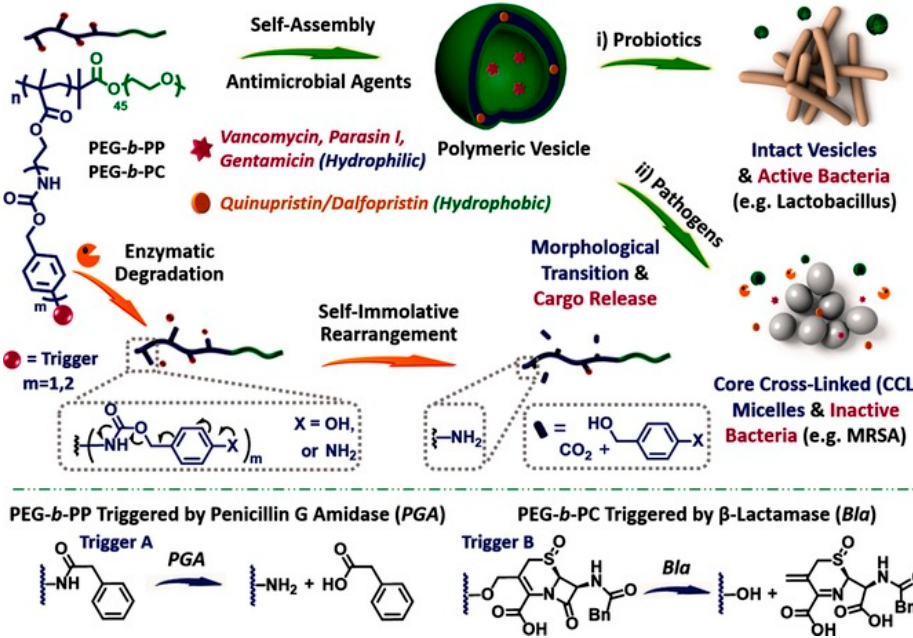
Figure 3. Enzyme-responsive polymer vesicles for bacterial strain-selective delivery of antibiotics [76] (Reprinted with permission from [76]). (Reprinted with permission from